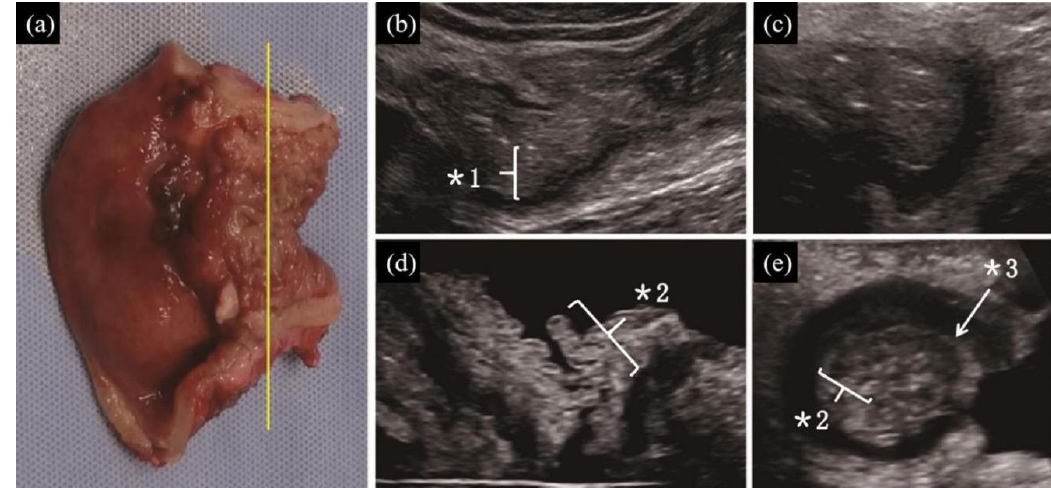
Figure 5. Fibrous stenosis with inflammatory polyps located in the junction of the ileocolon. ( a ) Gross morphology findings. The yellow line shows the location of the scanning area. ( b,c ) From longitudinal ( b ) and transverse ( c ) view by TAUS, the boundary between the mucosa and the submucosa disappear with mild increased echogenicity ( ＊ 1). There is a large area of adipose tissue wrapped around the intestinal tract. ( d,e ) Transverse view of the affected section by WIUS (open view ( d ) and closed view ( e )). The mucosal, submucosal, and muscular layers, as well as the entire intestinal wall, are thickened. Slight heterogeneous hyperechogenicity (mixed with some hypoechogenicity) is found in the mucosal layer, suggesting inflammatory polyps ( ＊ 2). The submucosa is not very clear in the longitudinal view but is recognized in the transverse view, indicating homogeneous high echogenicity ( ＊ 3). Circumferential hypertrophy of adipose tissue is seen around the intestine. For this lesion, (1) TAUS determined that the submucosal and mucosal layers had an indistinct presence, whereas WIUS identified them as distinct; (2) TAUS could not detect changes in the thickness of the submucosal layer, whereas WIUS detected thickening of the submucosal layer; (3) TAUS and WIUS were consistent in detecting irregularities of the mucosal surface; (4) TAUS and WIUS successfully detected increased fat wrapping around the bowel wall; and (5) TAUS and WIUS did not detect fistula signs.